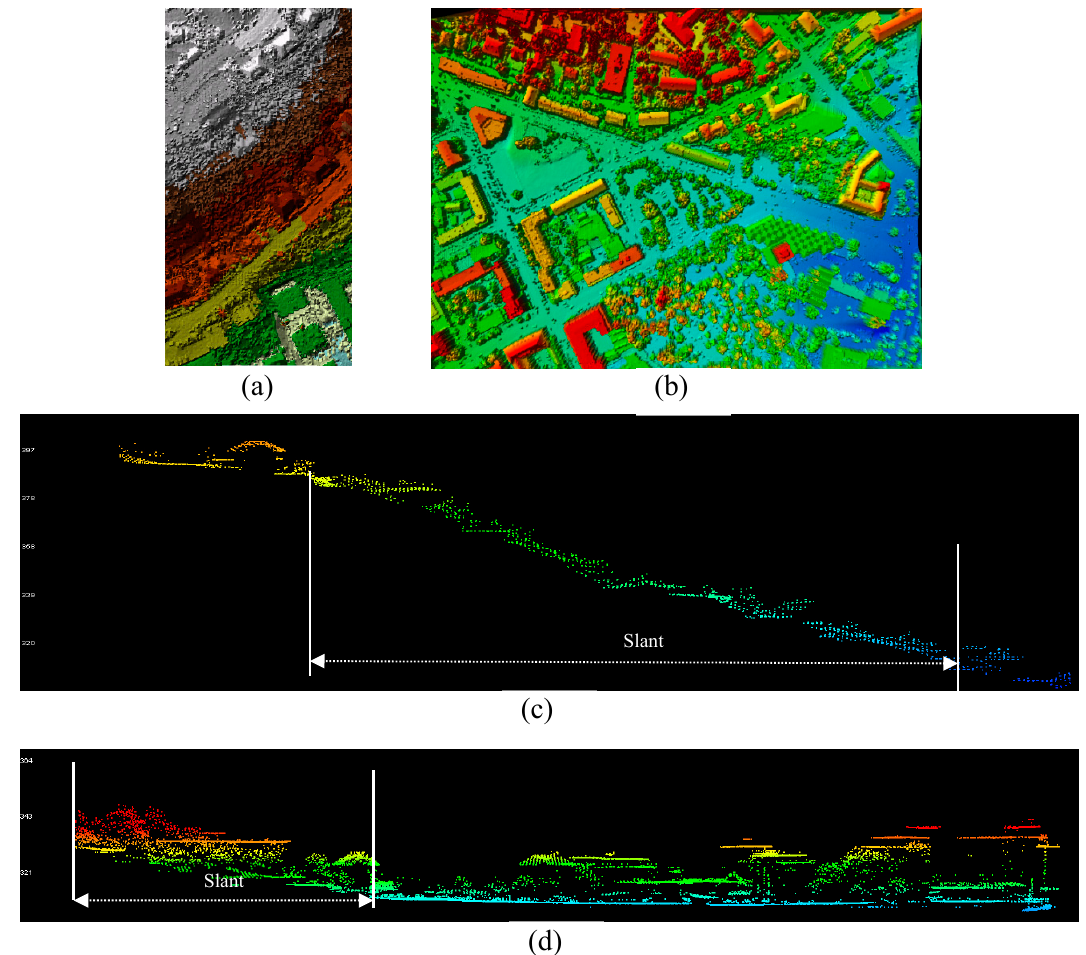
Figure 4. International Society for Photogrammetry and Remote Sensing (ISPRS) sample 11 top view ( a ) and sample 3 top view ( b ) with maximum slope varying between 10 (for sample 3) and 15 degrees (for sample 11, profile view of sample 11 ( c ), profile view of sample 3 ( d ).